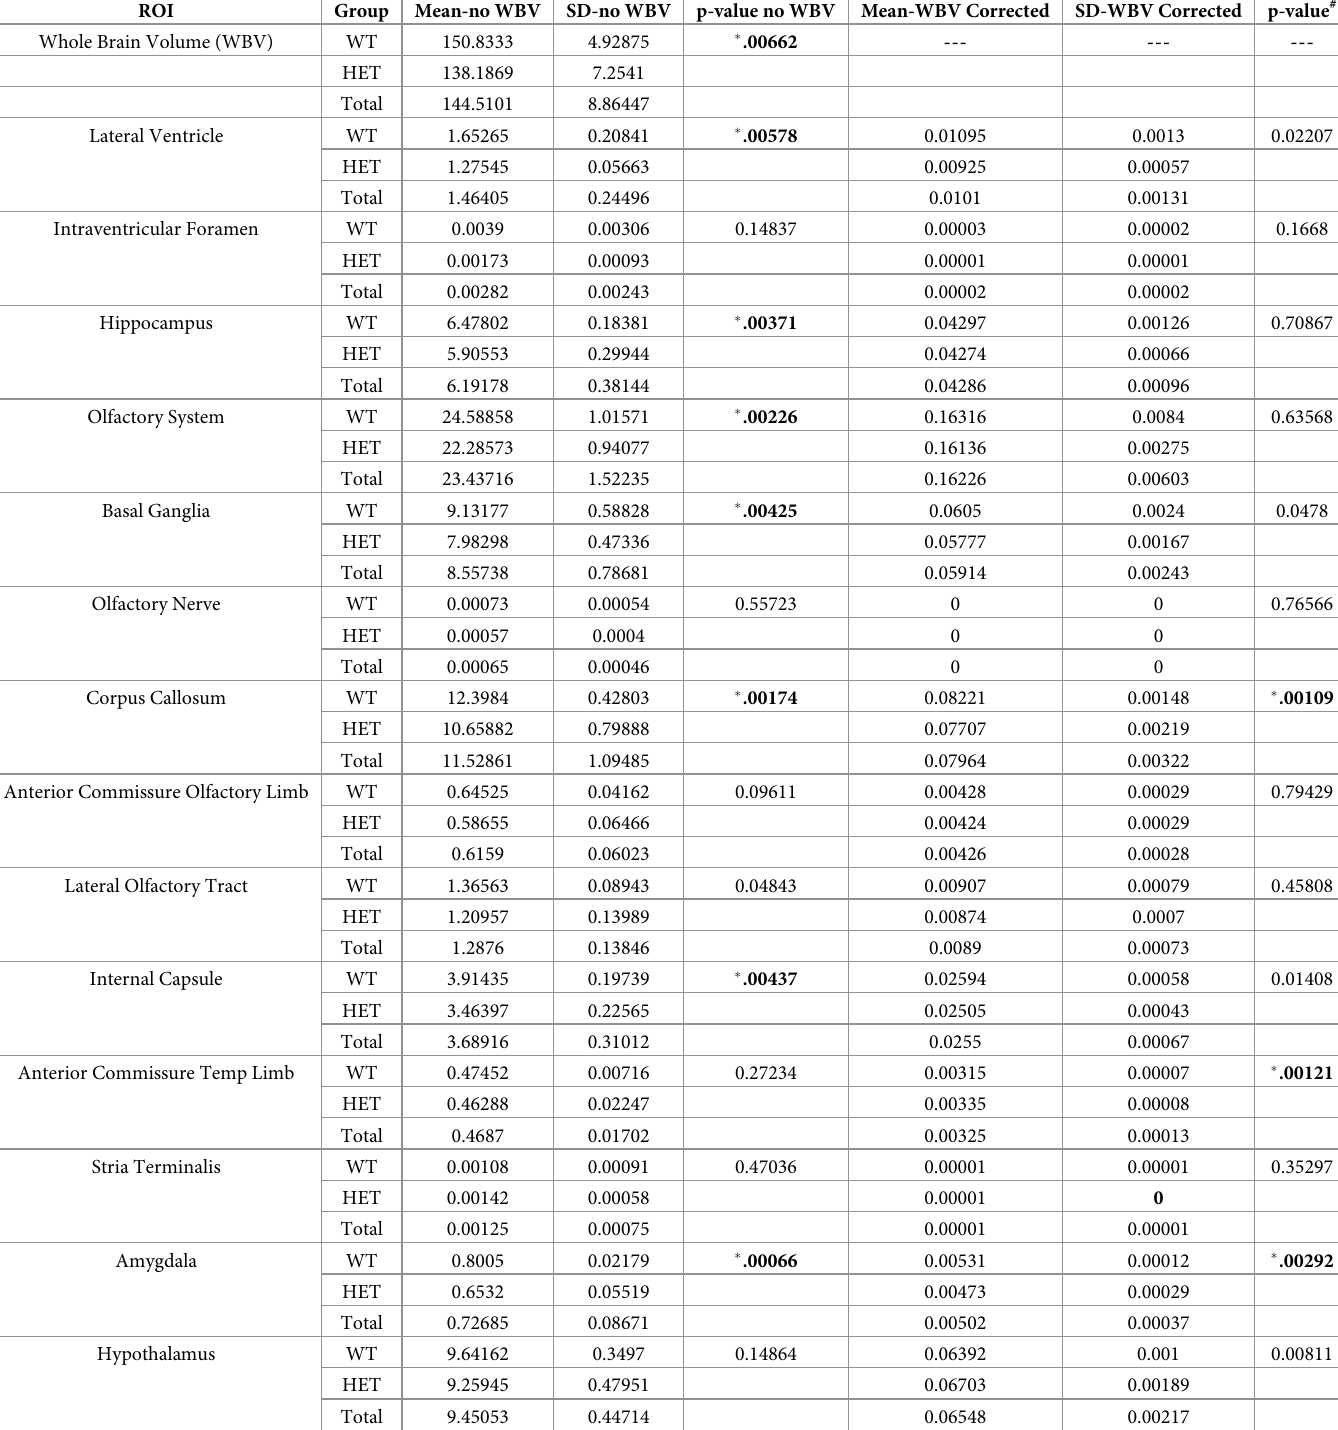
Table 3. Volumetric assessment of Foxg1 MUT/WT mice using MRI. Animals were assessed at ~48 wks of life, n = 6 for each genotype. p-values that were below threshold for Bonferroni multiple testing correction are shown in